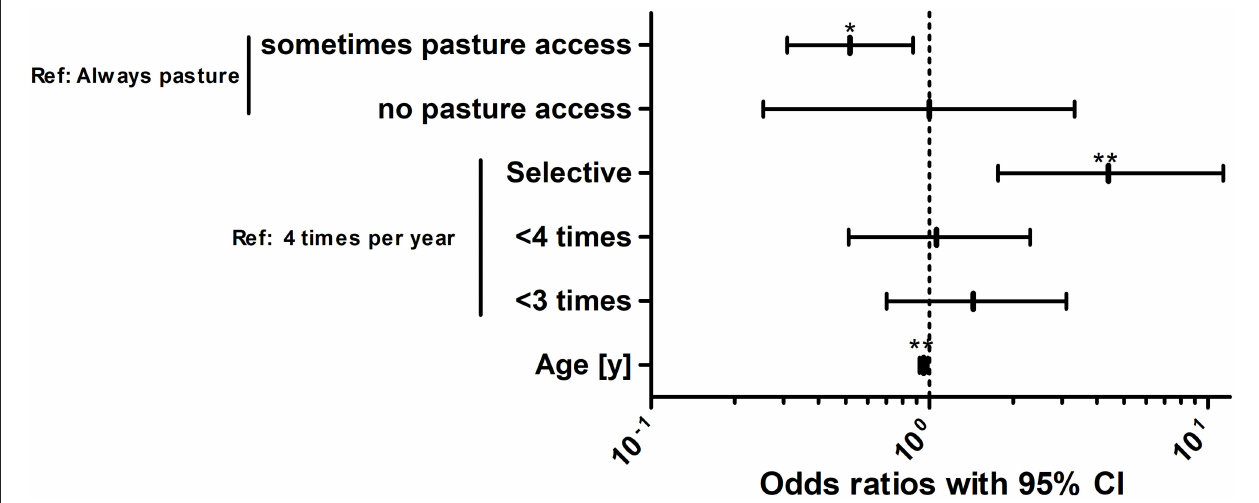
FIGURE 7 | Risk factor analysis for the odds of horses in the study population to be positive for antibodies against the Strongylus vulgaris recombinant SvSXP larval antigen. Risk factors for the odds to be seropositive or negative for antibodies against S. vulgaris using logistic regression analysis. The treatment scheme refers to whether horses were selectively dewormed based on previous diagnosis (selective) or regularly dewormed 1–2.5 times ( < 3 times), 3–3.5 times ( < 4 times), or 4 times per year on average. The age of the horses was rounded into whole years [y]. For foals and yearlings, the age was converted from months to years by dividing the month measurement by the conversion ratio 12. **, p < 0.01; *, p < 0.05.